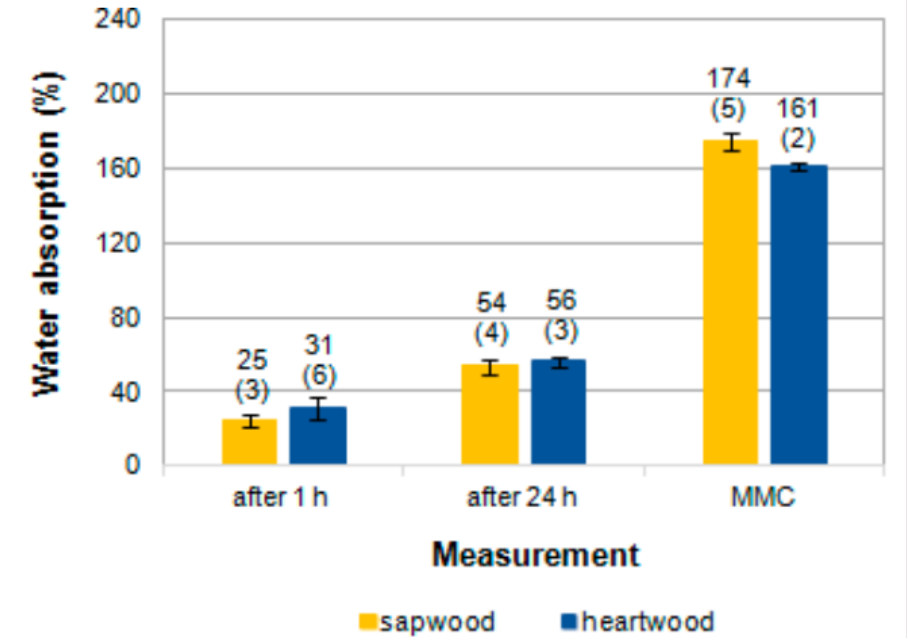
Figure 7. Water absorption (WA) of the sapwood and heartwood of oriental arborvitae; ±